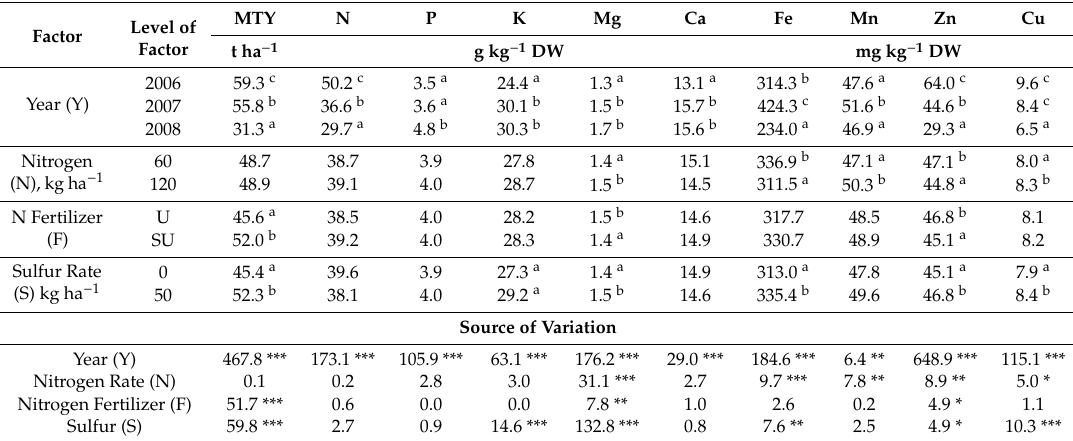
Table 2. Nutrient content in potato leaves at the onset of tuberization (BBCH 39 / 40). MTY: Marketable tuber